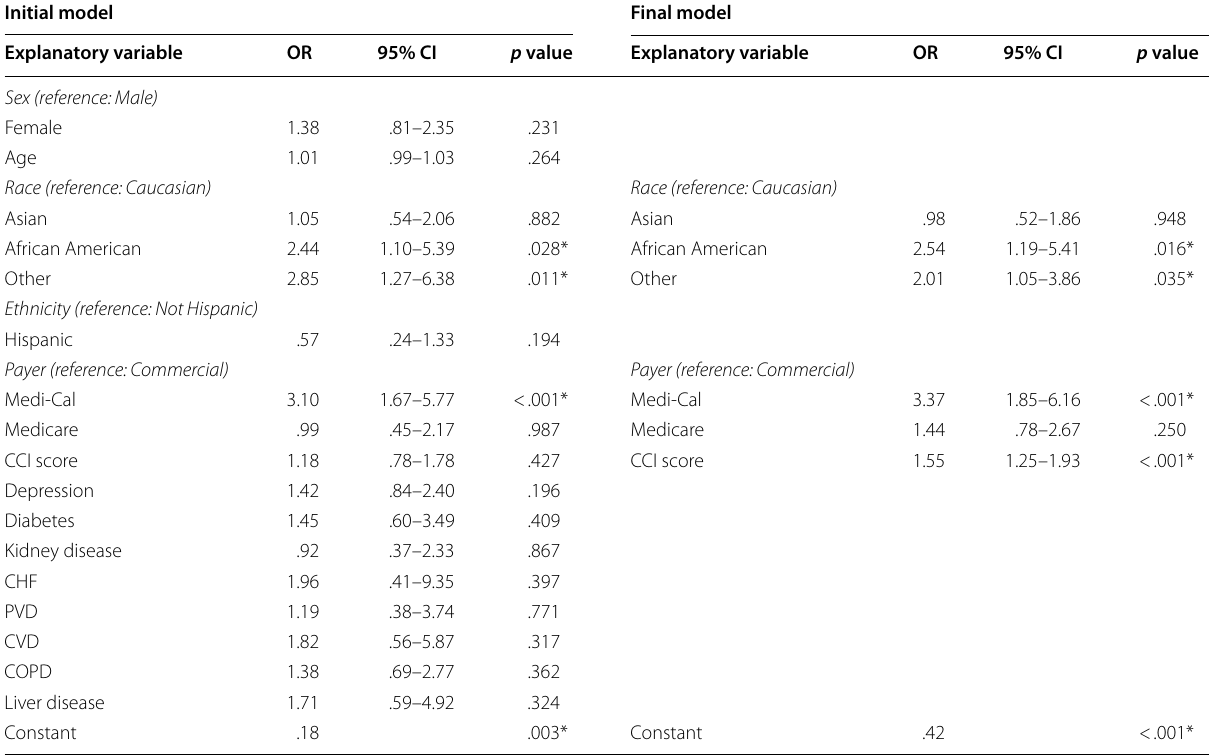
Table 3 Associations of patient characteristics with meeting PH-LOW